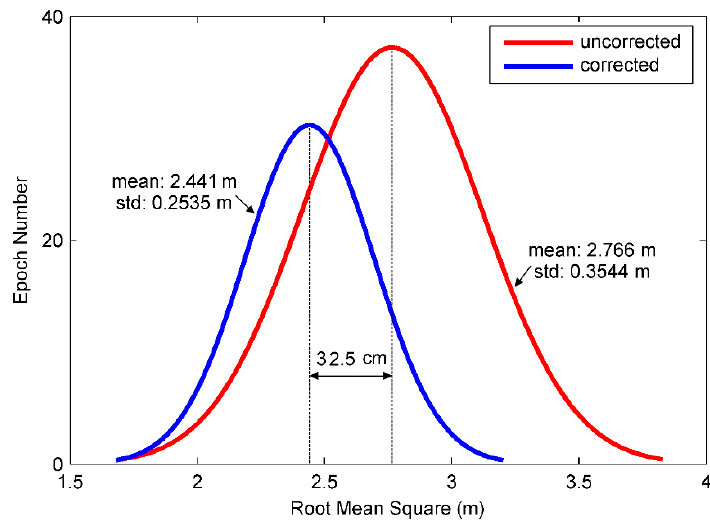
Figure 20. Distribution of root-mean-square error in kinematic single point positioning.